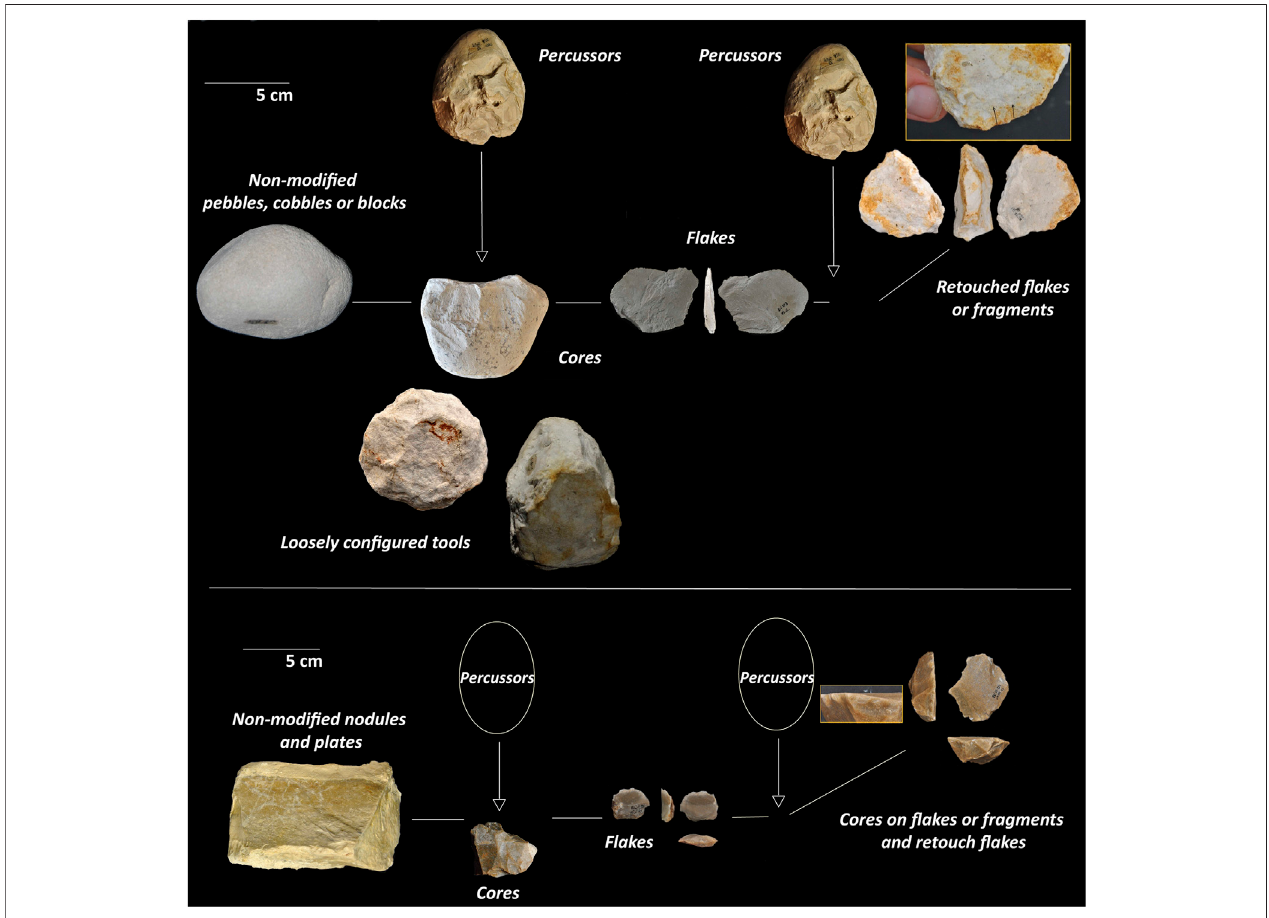
FIGURE 10 | Hypothetical limestone (upper) and fl int (bottom) chaîne opératoires reconstructed from the Barranco León assemblage. Each category represents a distinct stage of production/use, taking into account a range of chains of action (Titton, 2021).